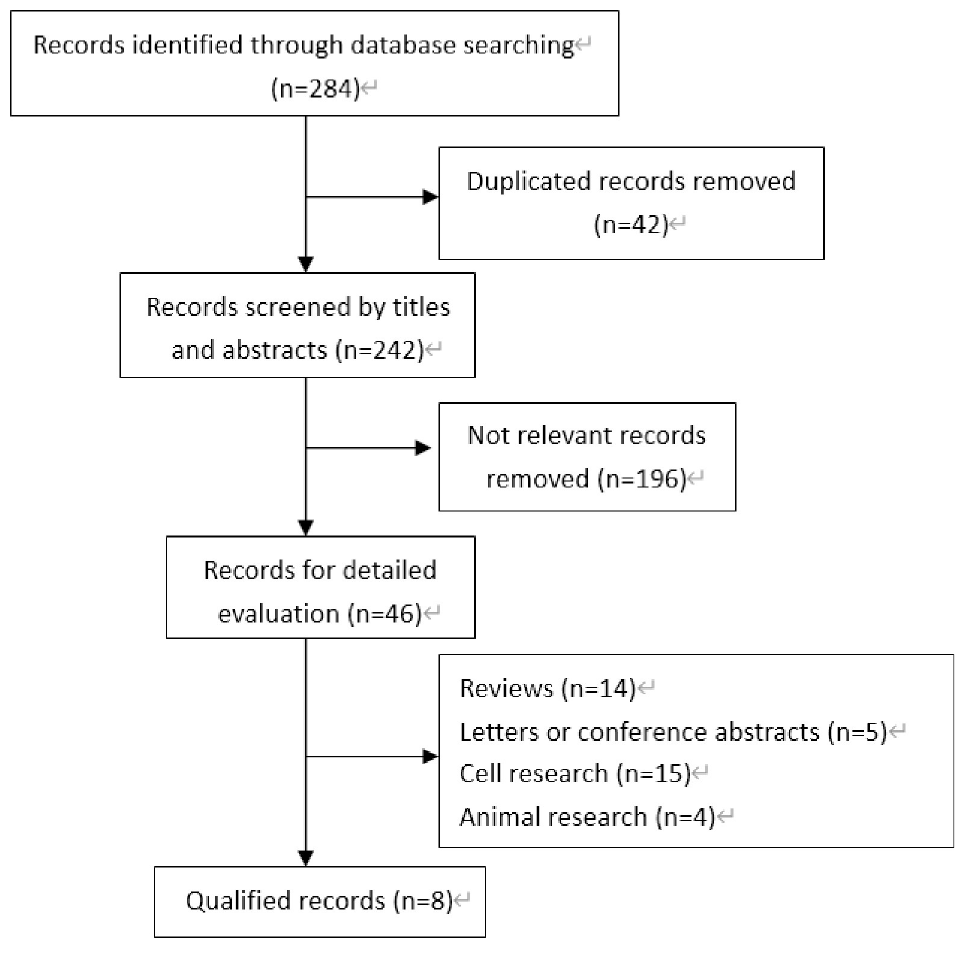
Fig 1. Flow diagram of study selection.